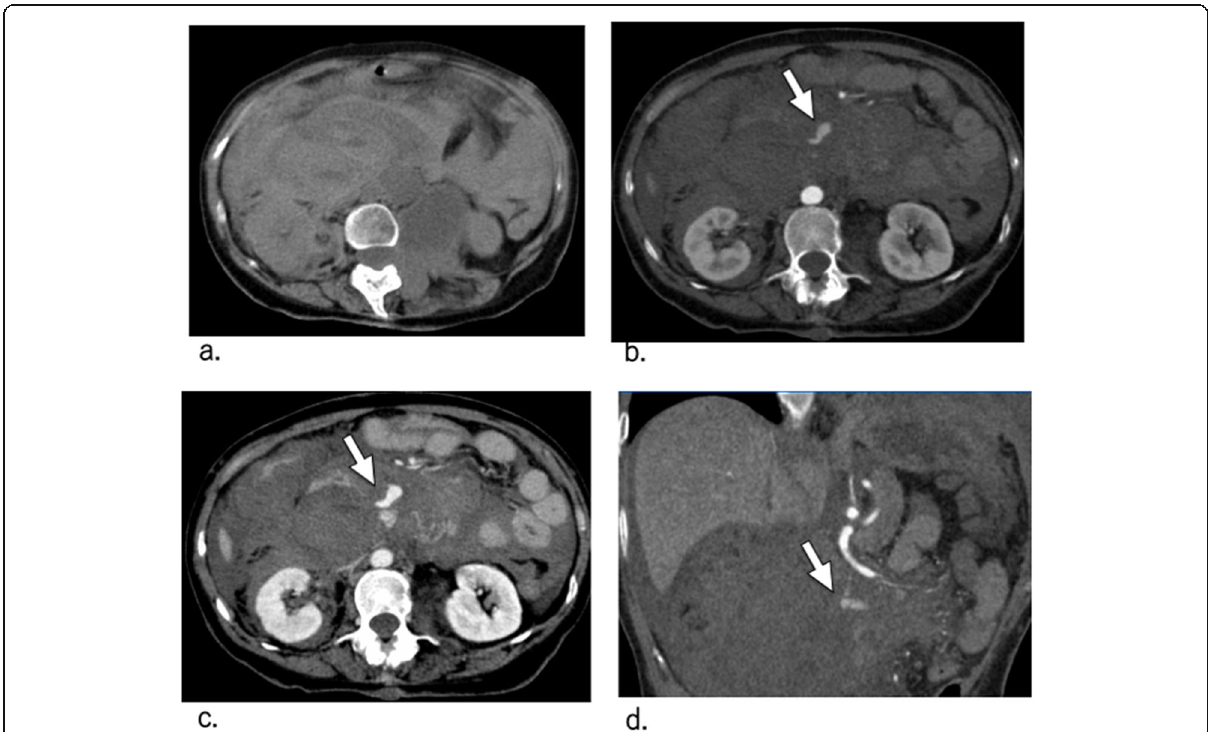
Fig. 1 Computed tomography (CT) at symptom presentation. a Non-contrast-enhanced CT image showing a large retroperitoneal hematoma around the duodenum and haemorrhagic ascites. b Contrast-enhanced CT arterial phase image showing a large retroperitoneal hematoma with definite pseudoaneurysm (white arrow). c Contrast-enhanced CT portal venous phase image showing a large retroperitoneal hematoma with definite pseudoaneurysm (white arrow). d Contrast-enhanced CT arterial phase coronal images (slab-maximum intensity projection) showing the superior mesenteric artery (SMA) and